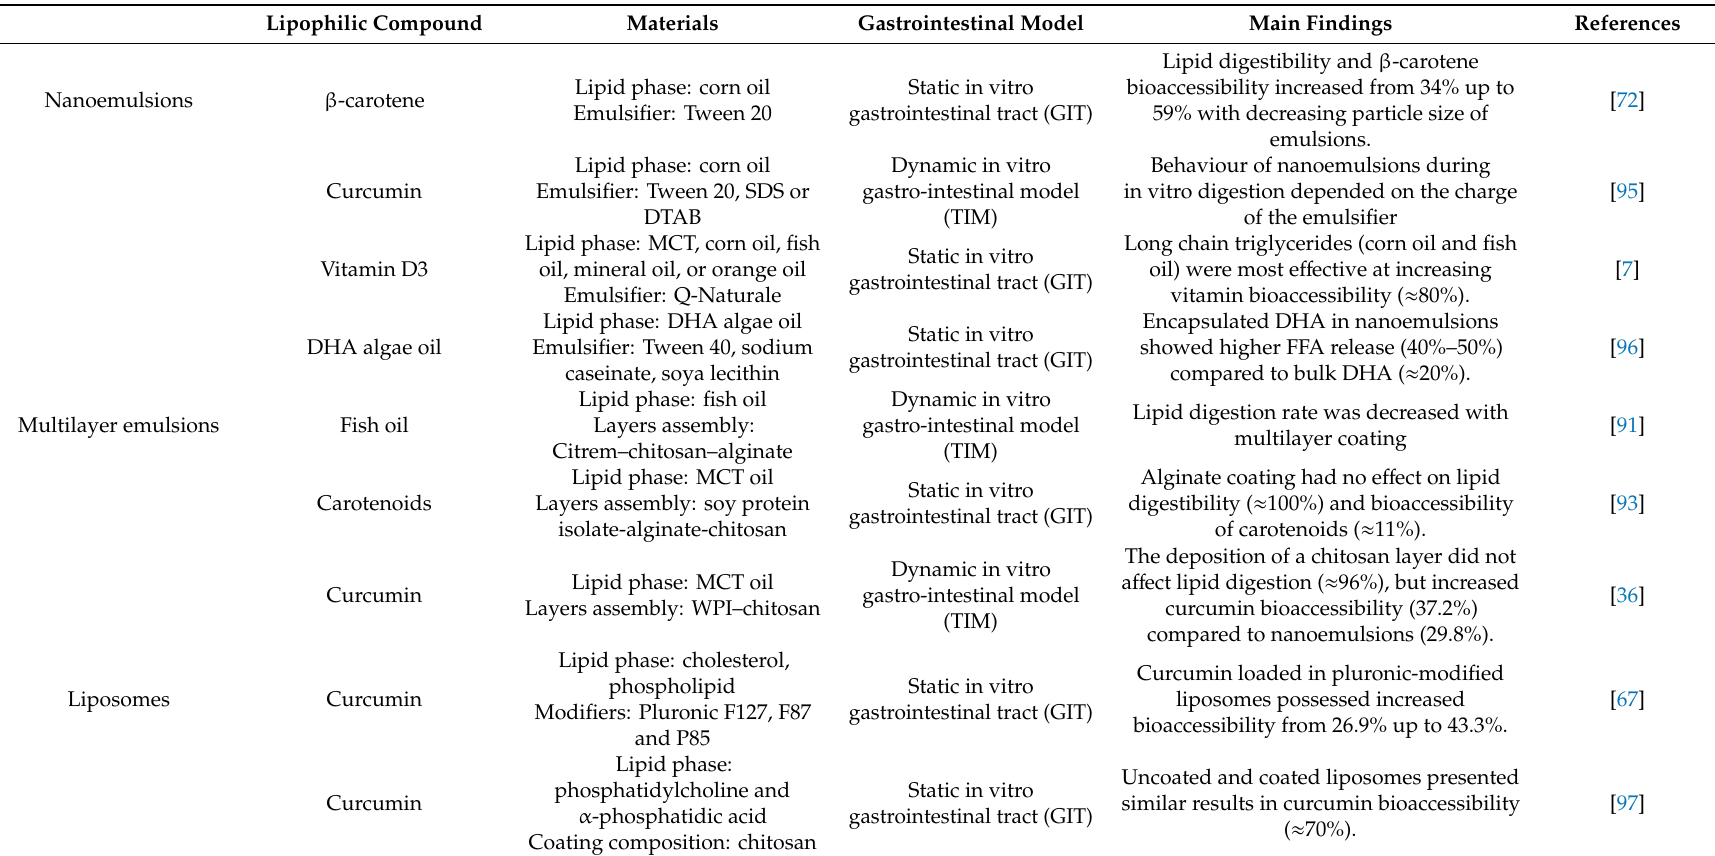
Table 2. Recent studies about in vitro lipid digestibility and bioaccessibility of encapsulated lipophilic bioactive compounds in nanostructured lipid-based delivery